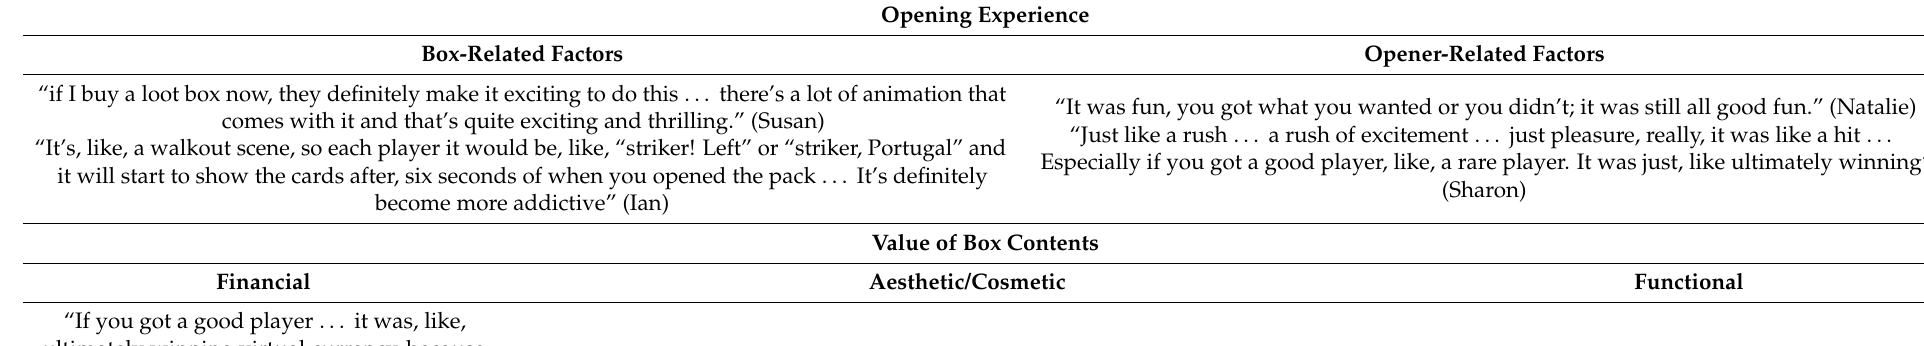
Table 2. Illustrative quotations by